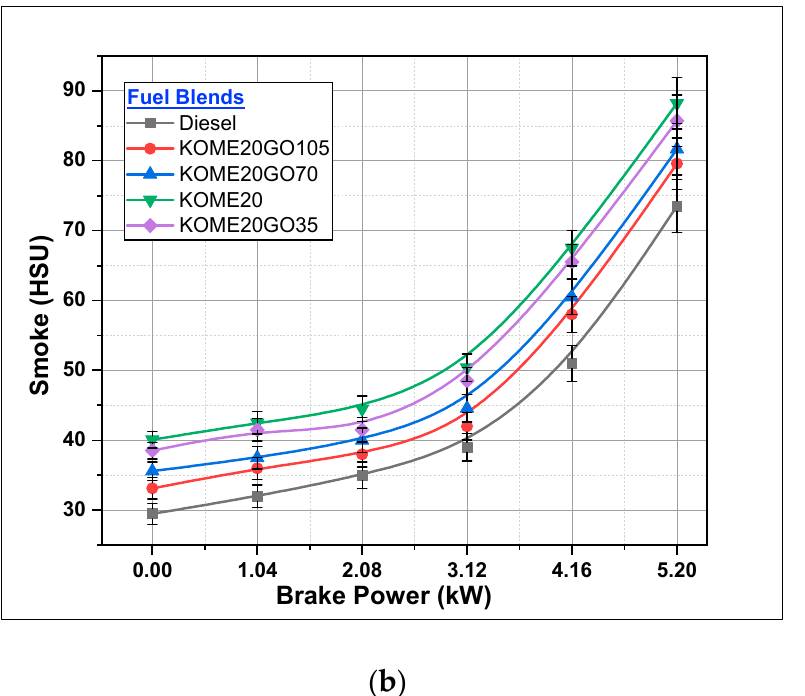
Figure 13. Variations in smoke formation with Biodiesel-Diesel-Nano blends ( a ) NOME20 ( b )